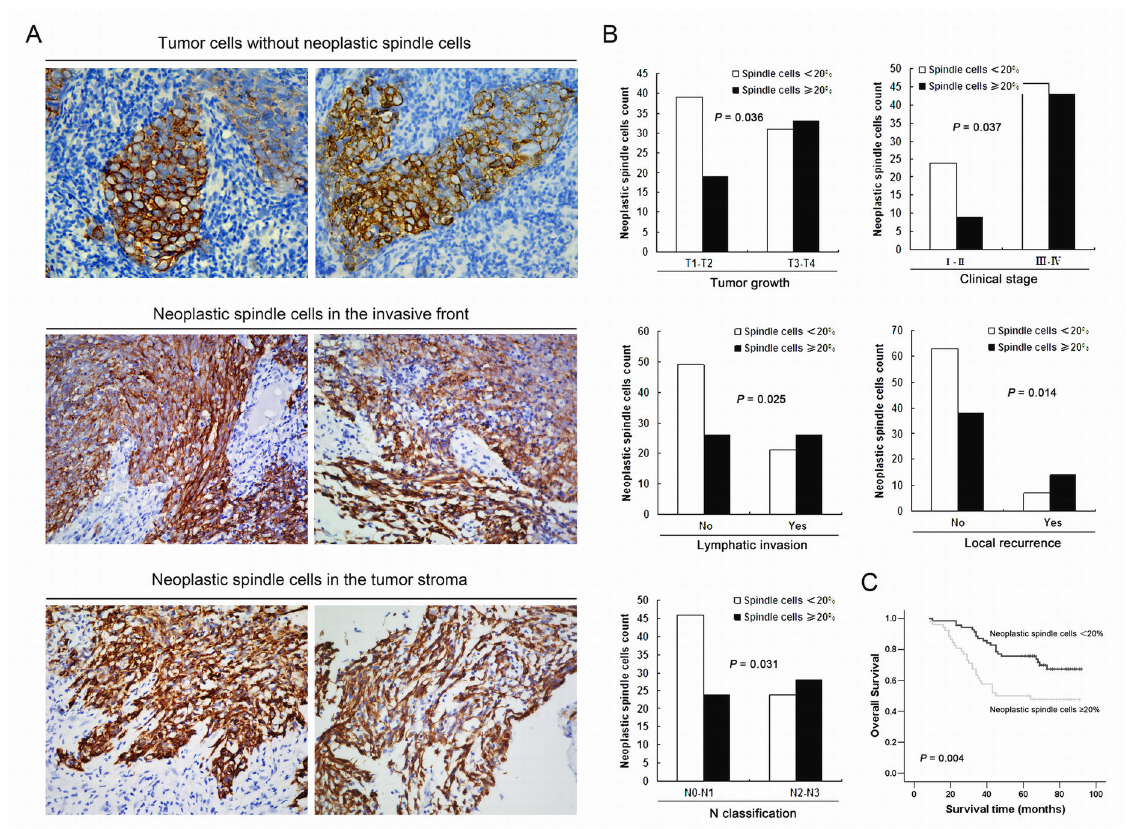
Figure 4. Spindle cells contribute to tumor aggressiveness and poor survival in NPC. (A) Representative examples showed that neoplastic spindle cells were frequently located at the invasive tumor edge or the invading surroundings (Pan-cytokeratin staining). (B) Correlation between the clinicopathologic characteristics and spindle cells in NPC. Columns: number of cases with >20% spindle cells vs <20. (C) Cumulative overall survival curves of 122 NPC patients according to the degree of spindle cells (≥20% vs <20%). Patients with high percentage of spindle cells (≥20%) had significantly shorter overall survival. P -values were calculated by the log-rank